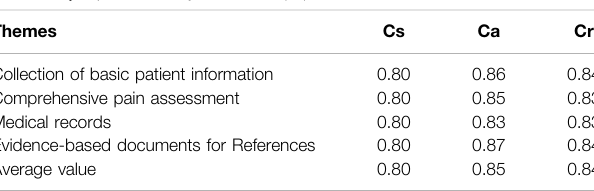
TABLE 5 | Expert authority coef fi cient (Cr) in the second round.